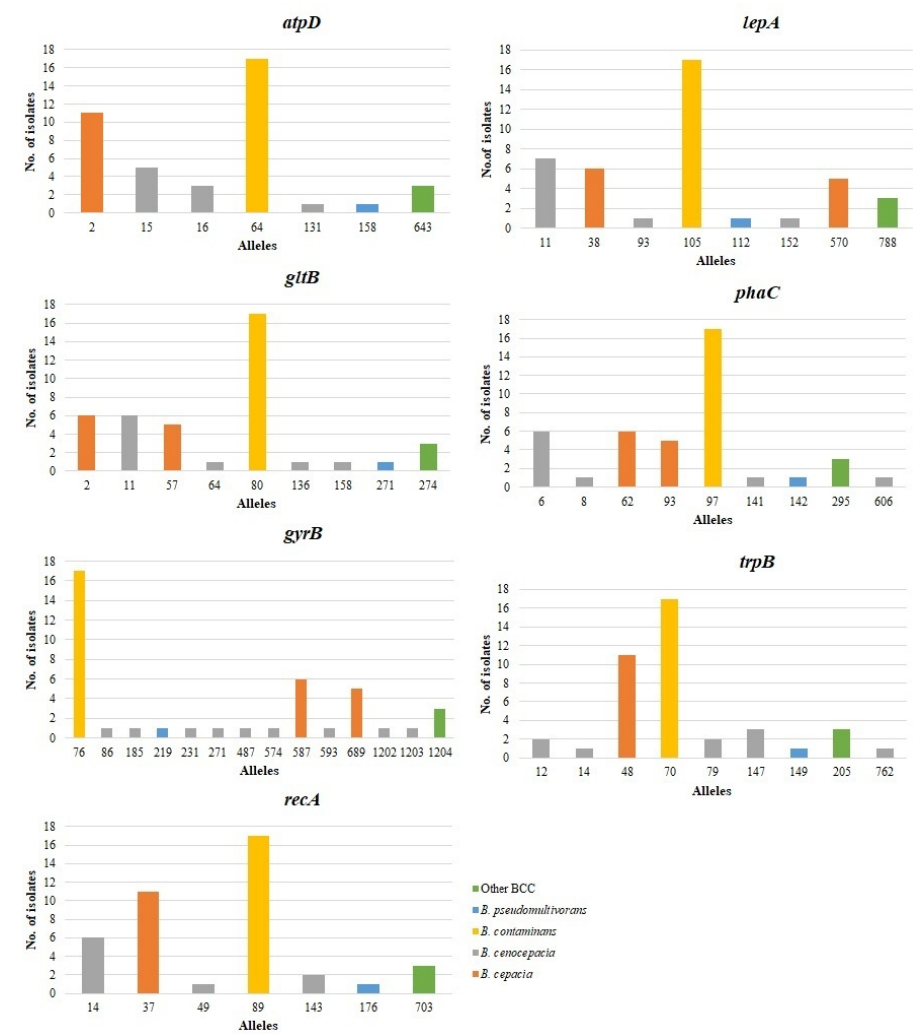
Figure 2. Frequency of alleles among the seven loci examined. For each locus, the number of times each allele occurred in different Burkholderia cepacia complex (BCC) species is shown.